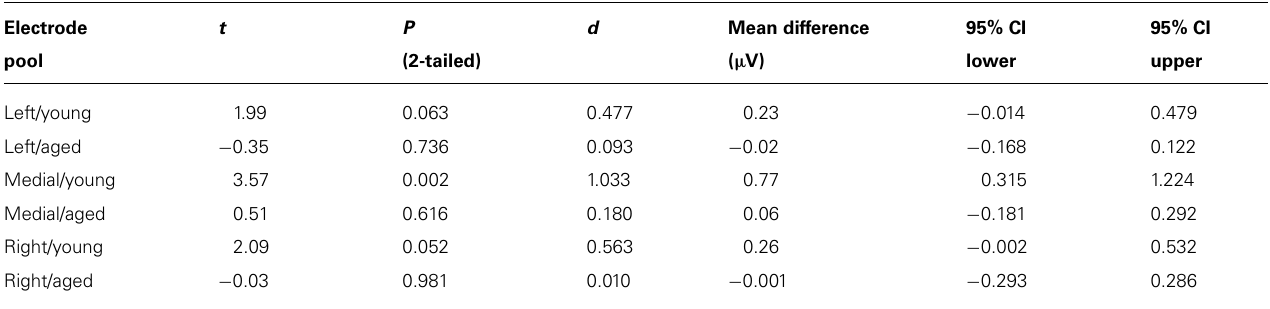
Table 1 | Latency range of 180–220